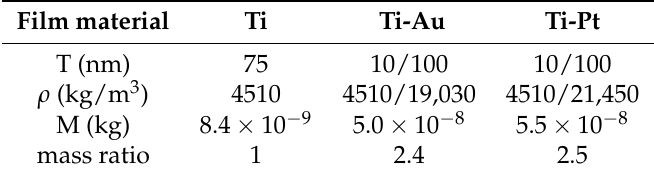
Table 2. Specimens. T: film thickness; ρ : density of the film material; M: total film mass; mass ratio: the ratio of the square root of the mass of the Ti-Au and T-Pt films to that of the Ti film.